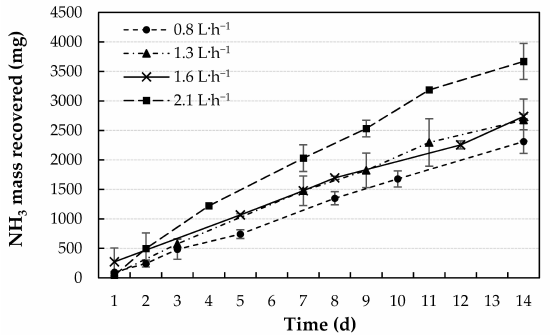
Figure 3. NH 3 mass recovered in the acidic solution for 0.8, 1.3, 1.6, and 2.1 L · h − 1 acid flow